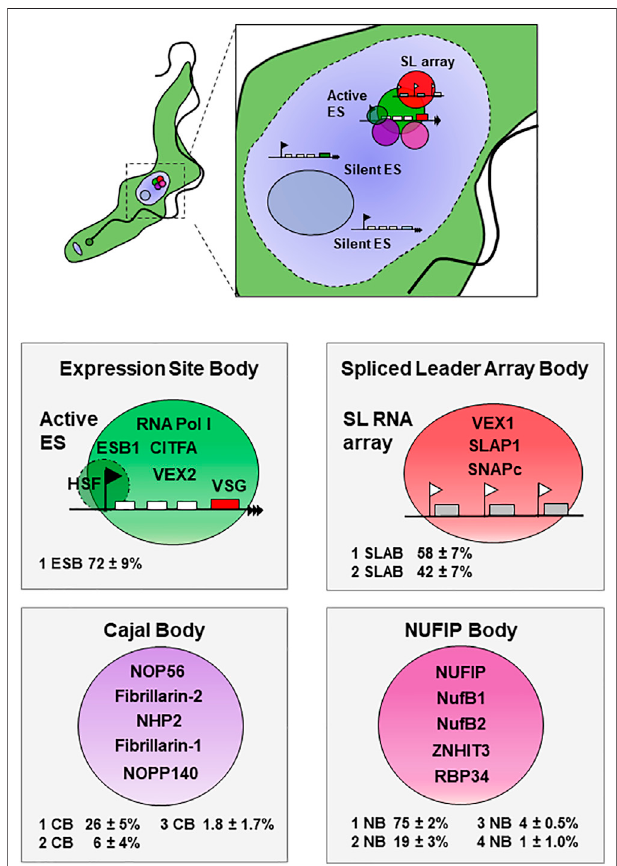
FIGURE1| AnassemblyofnuclearbodiescongregateattheactiveVSG expressionsiteAtthetopabloodstreamform(BF)trypanosomeisshownwith the nucleus (dashed circle) magni fi ed. This contains an assembly of nuclear bodies (coloured circles) at the active VSG expression site (ES), as well as anucleolus (bluecircle).The active EShas aPolIpromoter indicated witha black fl ag, various Expression site associated genes (ESAGs) with white boxes, and the VSG with a red box (not drawn to scale). The active ES associateswithatleastoneofthesplicedleader(SL)RNAgenearrays,shown with individual SL RNA genes (grey boxes) transcribed from Pol II promoters (white fl ags). Nuclear bodies are shown below as large coloured circles with selected associated protein components indicated. The Expression site body (ESB) (large green circle) at the active ES is associated with a highly SUMO- ylated focus (HSF) (dark green circle). The Spliced Leader Array Body (SLAB) (red circle) associates with the SL RNA gene arrays, of which at least one is associated with the active ES. Two additional nuclear splicing bodies associating with the active ES include the Cajal Body (violet circle) and a novel NUFIP body (purple circle). These nuclear bodies (with the exception of the ESB)arealsofoundinprocyclicform T.brucei. ThepercentageofBF T.brucei cells in G 1 containing one or more of these nuclear bodies is shown in the respective panels [data from (Budzak et al., 2022)].